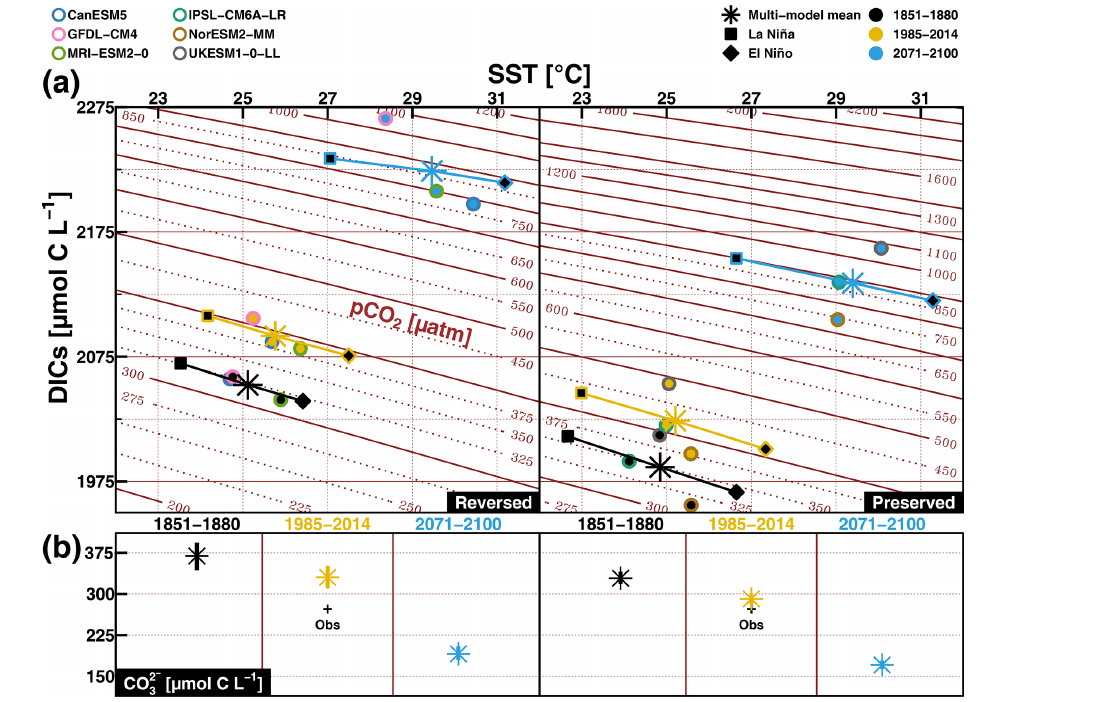
Figure 7. Mean SST (in ◦ C) versus mean salinity-normalized DIC (DICs, in µmolCL − 1 ) over the early historical (1851–1880), contem- porary (1985–2014), and future (2071–2100) periods in the EP domain simulated by all reversed and preserved ESMs ( a , circle markers). The multi-model mean values of SST and DICs (asterisk markers) from each ESM group, together with their respective mean values during La Niña (square markers) and El Niño (diamond markers), are also depicted for the three periods. Isolevels of p CO 2 for varying SST and DICs are given in the background. Panel (b) shows the multi-model range and mean of surface carbonate concentration (in µmolCL − 1 ) for both groups and three